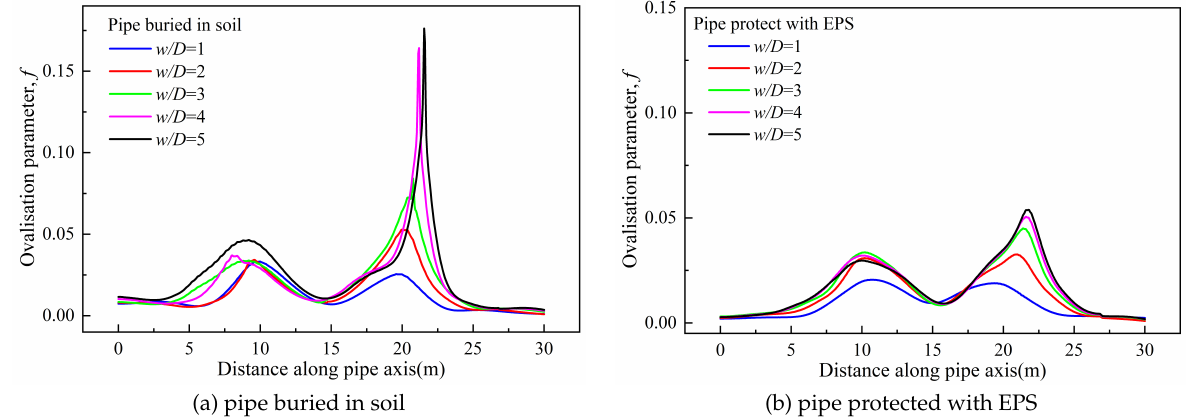
Fig. 5. Ovalisation parameter along pipe axis with different w / D